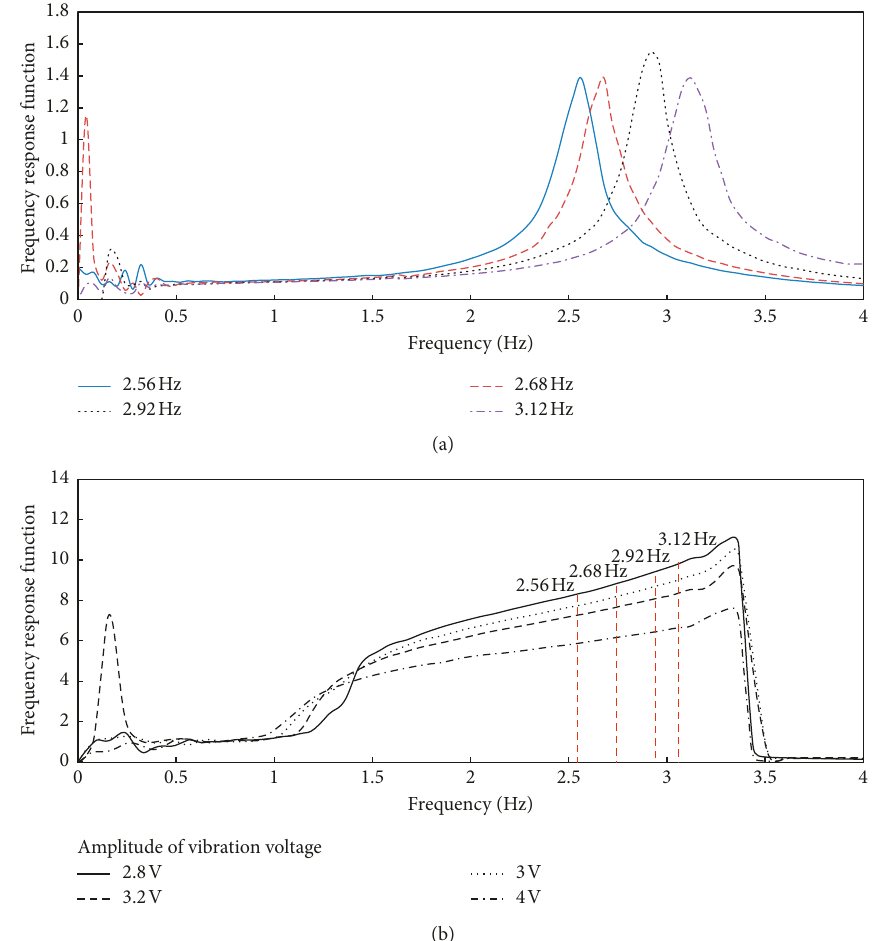
F IGURE 18: (a) Frequency response function of the offshore platform under different masses. (b) Natural frequency distributions of an offshore platform under the TMD’s frequency response